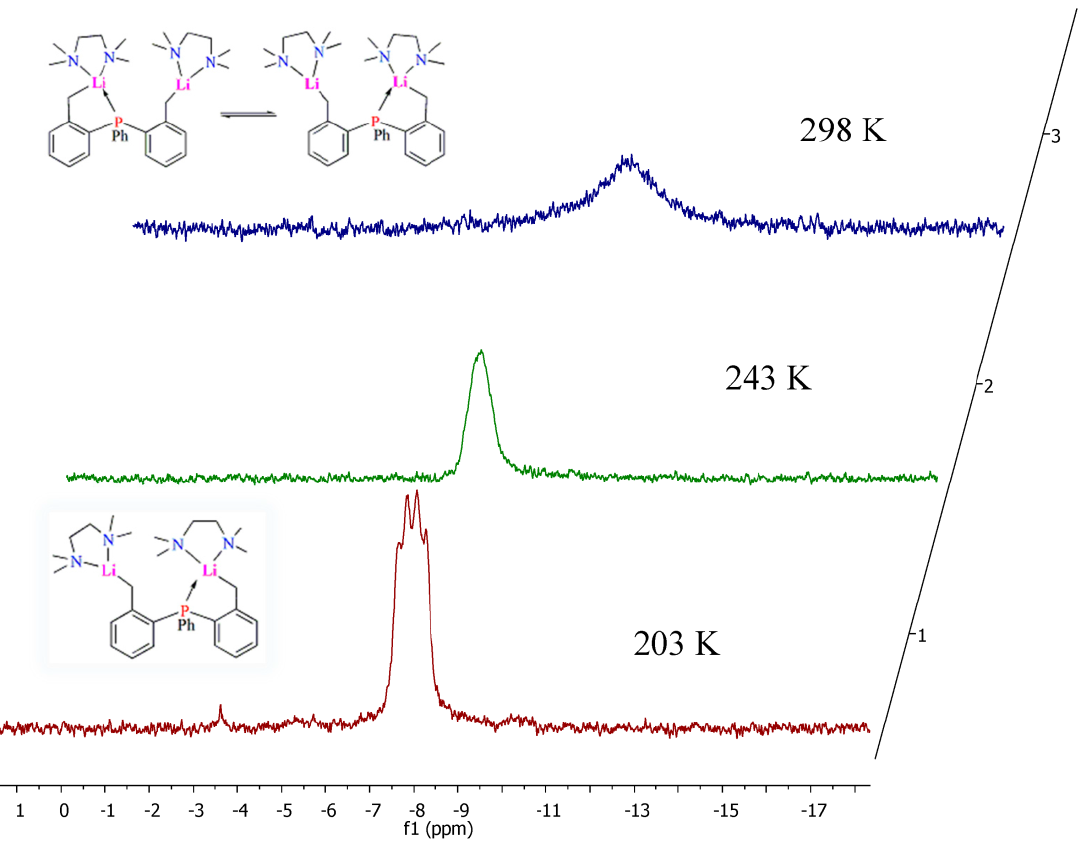
Figure 4. 31 P{ 1 H} NMR spectra in toluene-d 8 of 2-Li 2 at three different temperatures.